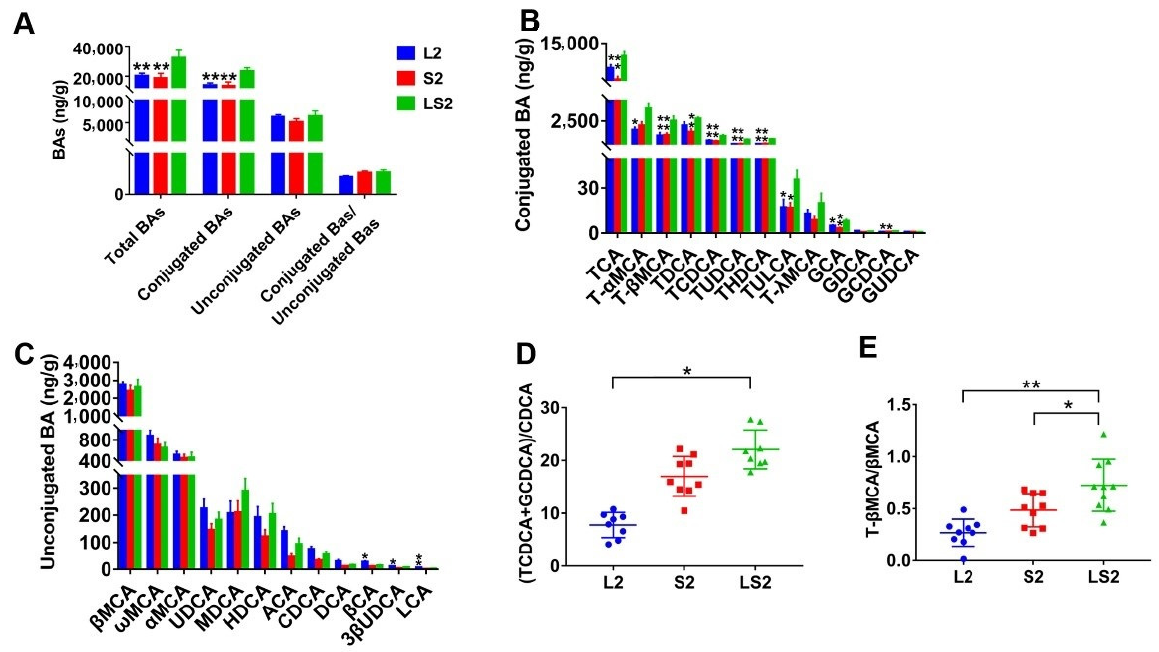
Figure 9. Impacts of various oil/fat diets on liver bile aids. ( A ) Total BAs; ( B ) conjugated BAs; ( C ) unconjugated BAs; ( D ) ratio of (TCDCA+GCDCA) and CDCA; ( E ) ratio of T- β MCA and β MCA. Ratio of (TCDCA+GCDCA) and CDCA was analyzed using Kruskal–Wallis, significance was deter- mined by two-tailed unpaired t test, p value was adjusted using Bonferroni. “*” denotes considerable differences at p < 0.05; “**” shows marked differences at p <